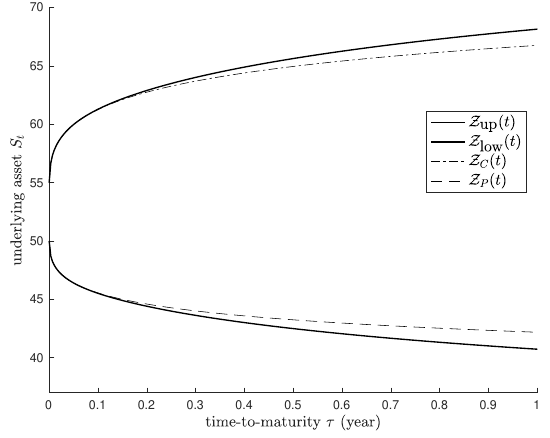
Figure 7. The comparison of the two free boundaries with those of the American call and put options,